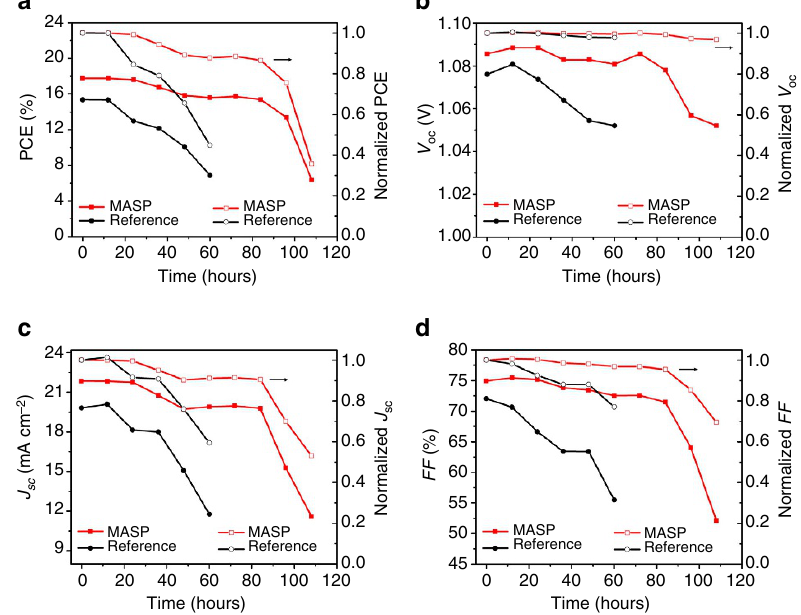
Figure 5 | Device stability under continuous working condition. Stability plots of ( a ) PCE, ( b ) V oc , ( c ) J sc and ( d ) FF as a function of time (left axis). The normalized values are also included for better comparisons (right axis). The device stability was measured under continuous AM1.5G solar illumination in ambient environment without